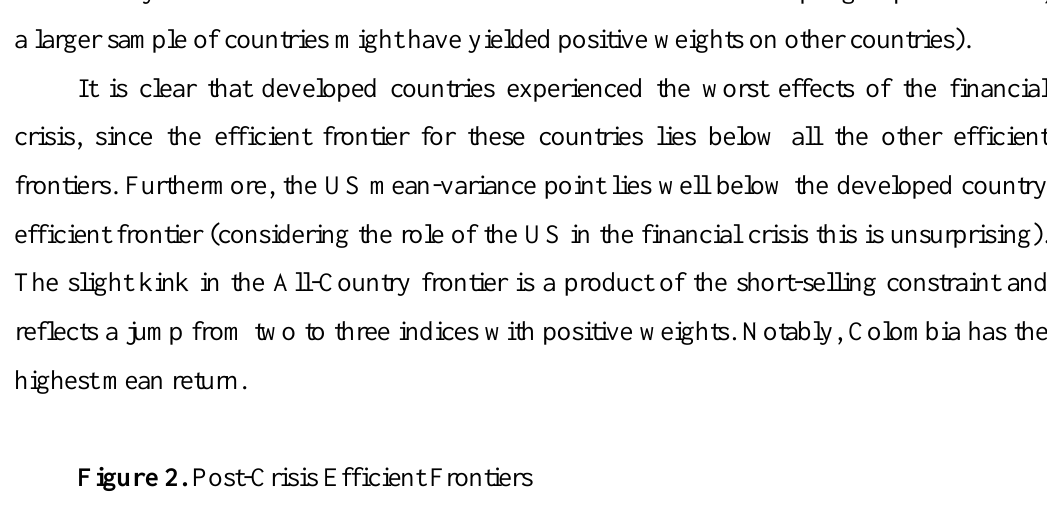
Figure 2. Post-Crisis Efficient